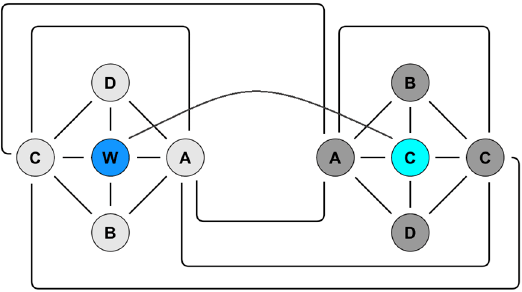
Figure 6. Circuit schematic showing the source multiplexing and the calibration resistance selection. Analog switch inputs A0 to A2 allow the different electrode configurations for the impedance measurement. Designation 1 and 2 correspond to the working and counter electrode, respectively.